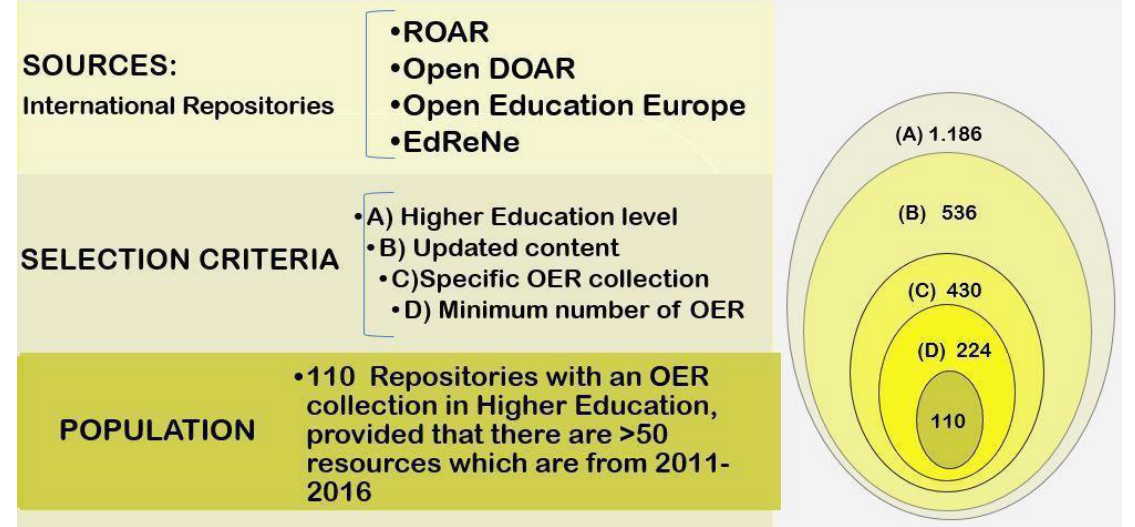
Figure 1 . Selection of the ROER population (Santos-Hermosa, Ferran-Ferrer, & Abadal,